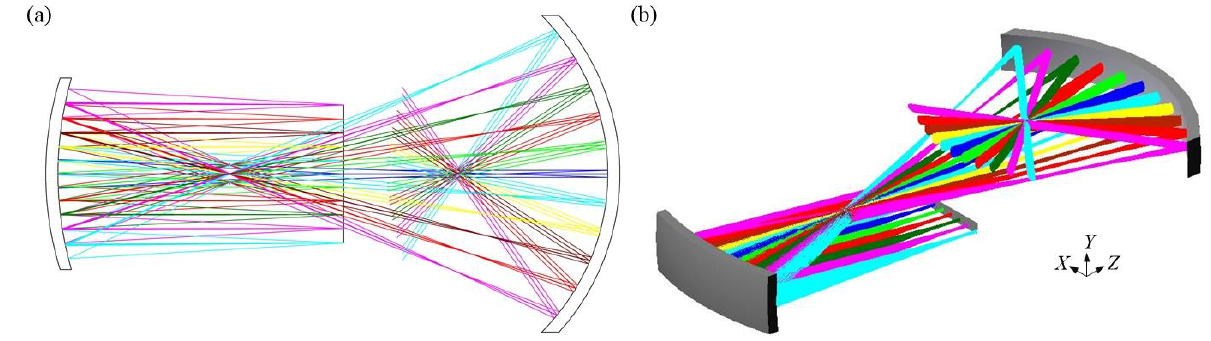
Figure 7. Final designed layout of the compact UFOTAS: ( a ) layout in XOZ plane, ( b ) 3D layout.